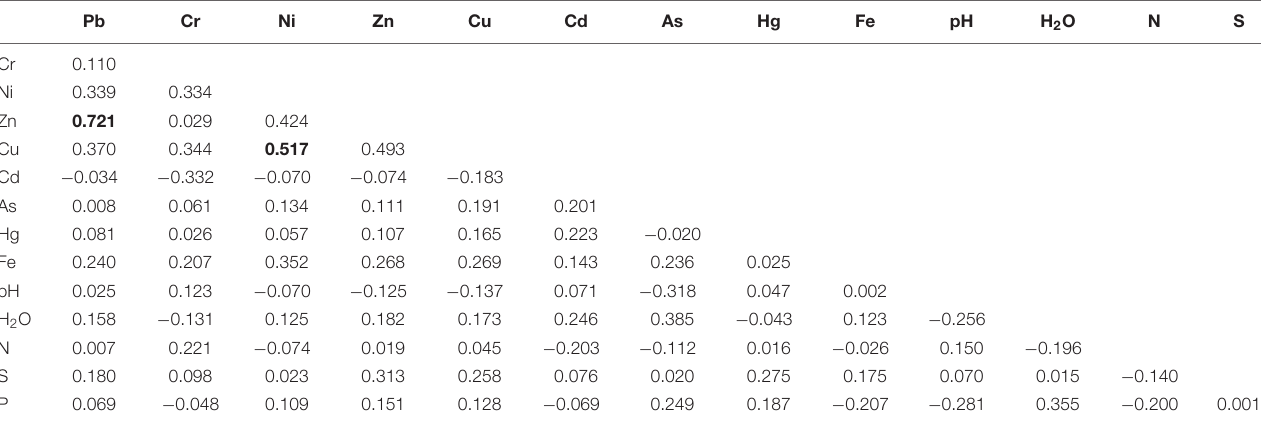
The significance level p < 0.05 (two-tailed).